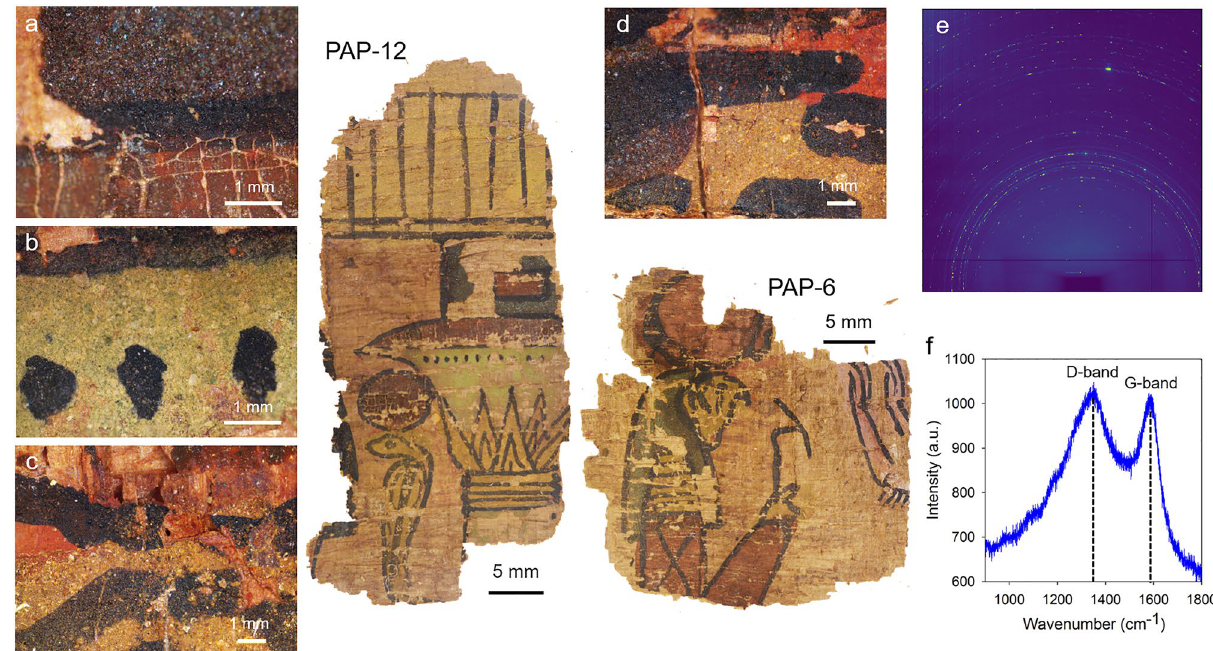
Figure 1. Papyrus fragments PAP-6 and PAP-12 from the Champollion museum (département de l’Isère, Vif, France), showing scenes from the Book of the Dead. ( a ) Detail of the column decoration (PAP-12) obtained from optical microscopy with a blue part, a black line, and a red part where cracks are observed. ( b ) Detail of the column decoration (PAP-12) with dark spots apposed on green paint. ( c ) Region between the red solar disk and the cobra head (PAP-12), with a red part corresponding to the preparatory drawing. ( d ) Detail of the God head (PAP-6) with a yellow paint used to color the face of the God, and a blue one for his cap. The red part corresponds to the preparatory drawing. ( e ) Two-dimensional diffraction image showing spotty diffraction rings. ( f ) Raman spectrum recorded on a black stripe decorating the cloth of the deceased